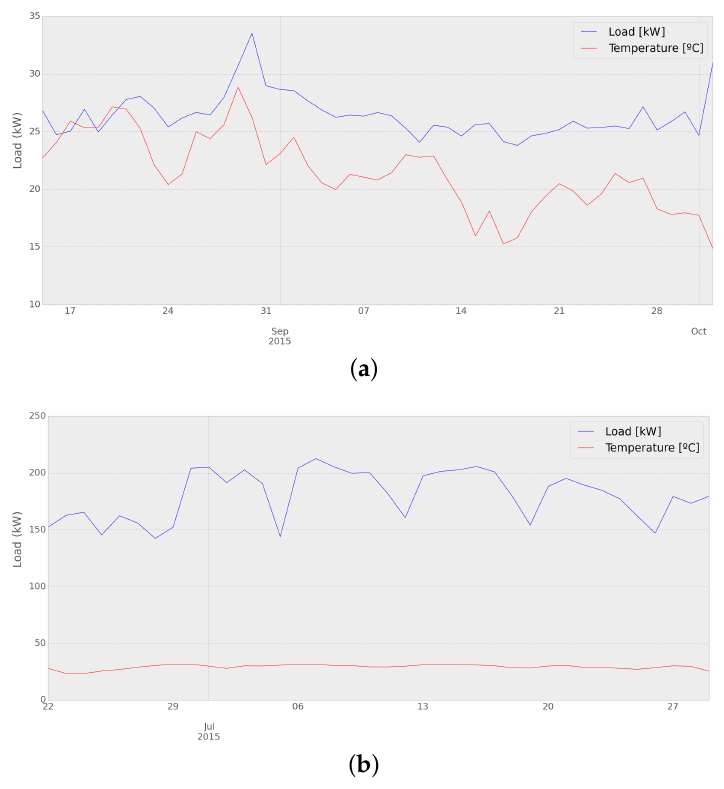
Figure 14. Load and temperature curves during testing period: ( a ) Network 1; ( b ) Network